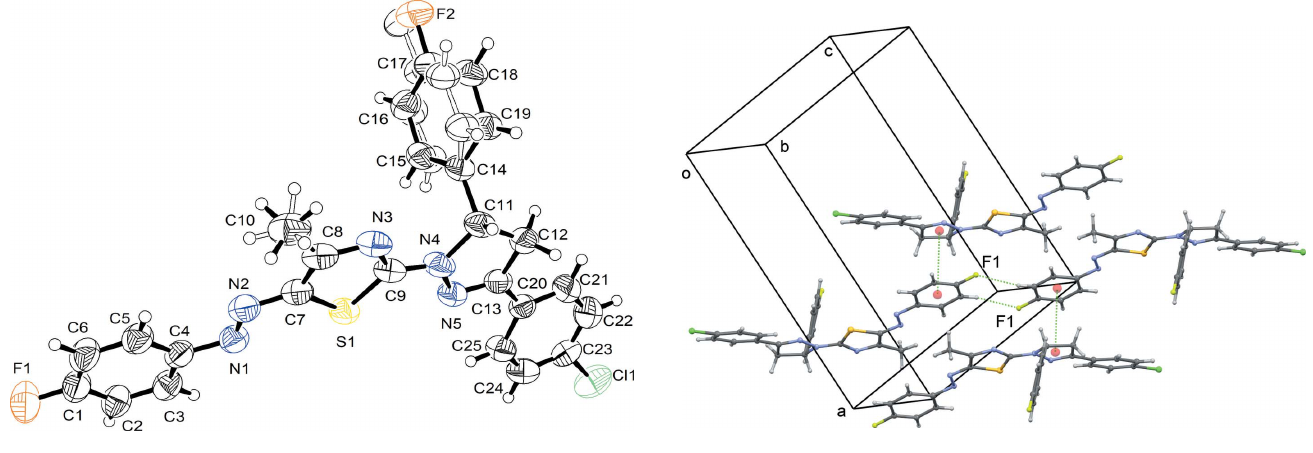
Figure 1 ORTEP representation of the title molecule showing 50% probability